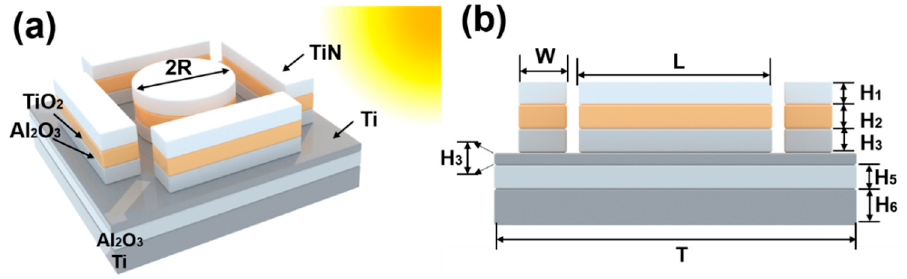
Figure 1. ( a ) The principle diagram of the ultra-broadband solar energy absorber. ( b ) Front view of the absorber.